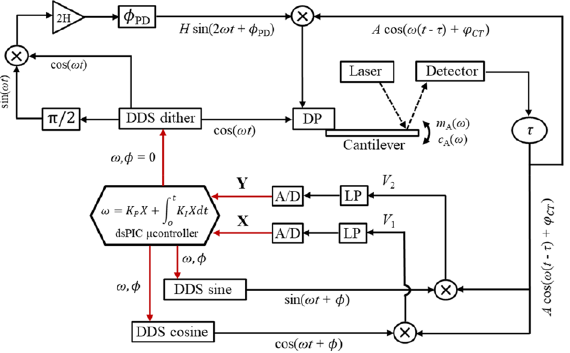
Figure 1. Schematic of the electrical signals throughout the developed